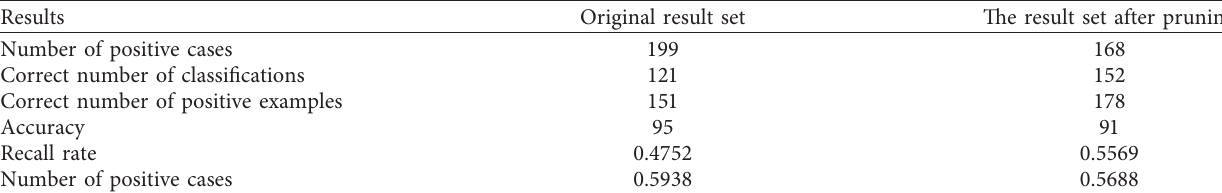
Table 2: Decision results of the test set.